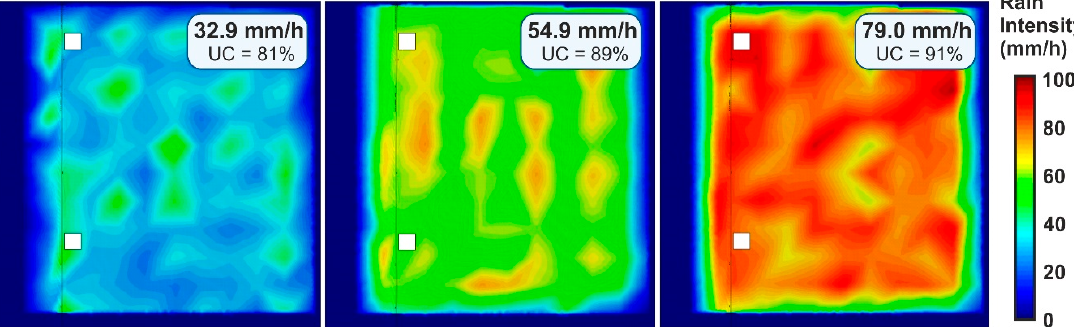
Figure 6. Rain intensity map of the physical model surface, which has an approximate area of 36 m 2 , for the three intensities that the rainfall simulator is able to generate. Plots include the mean rainfall intensity measured and the Christiansen’s uniformity coefficient (UC) resulted.